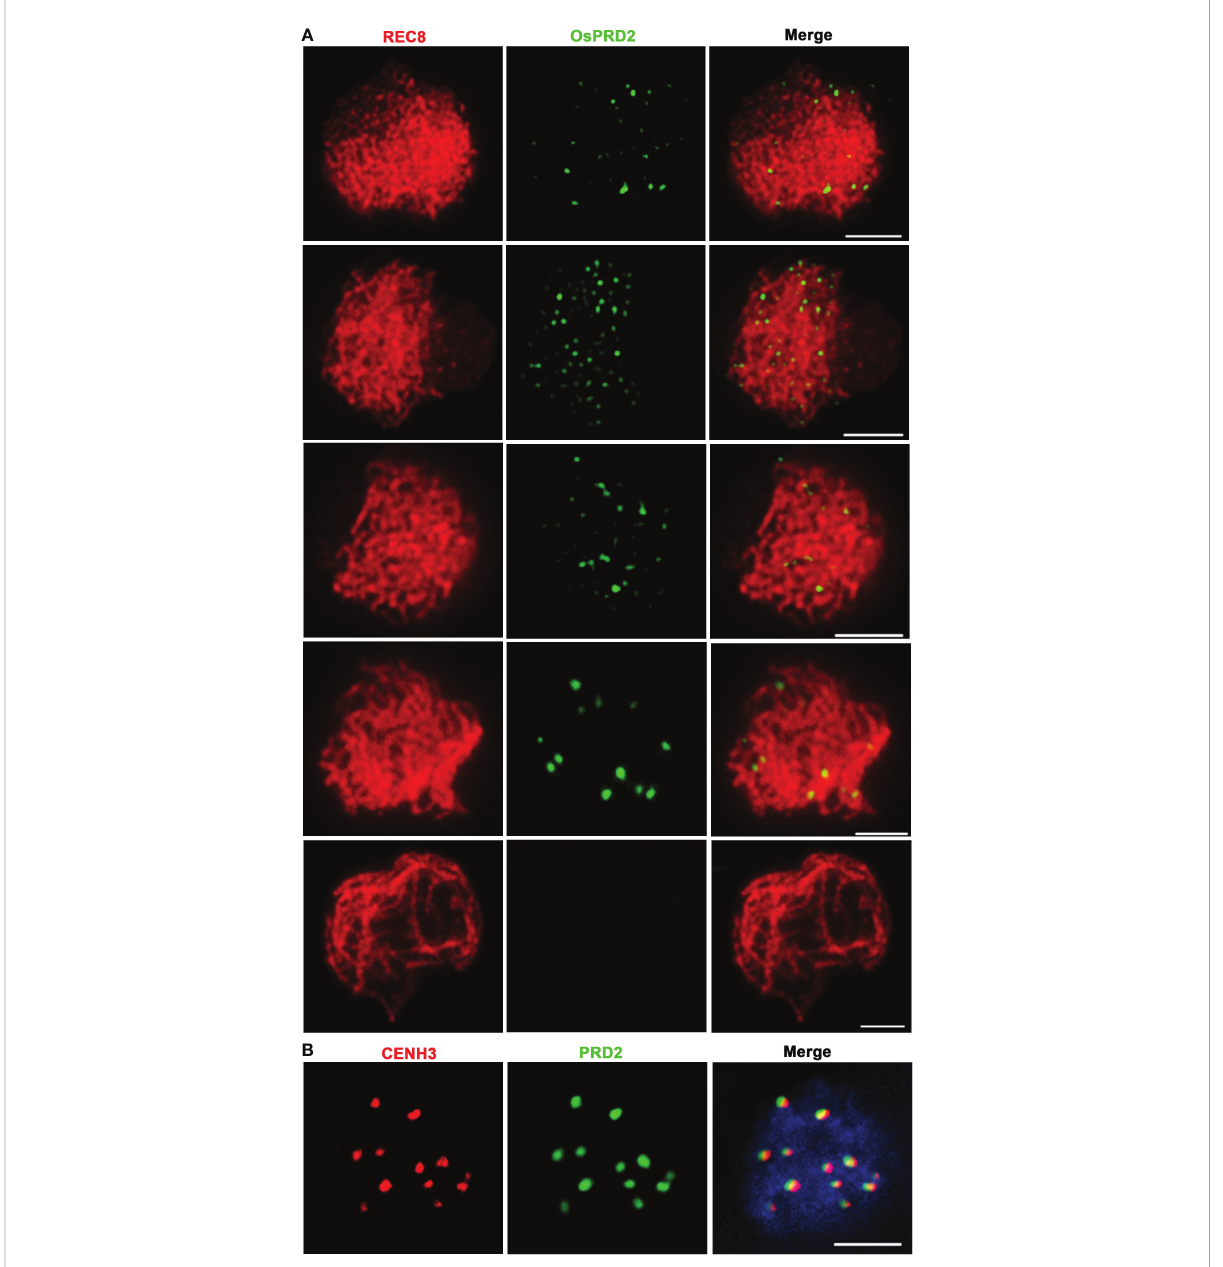
FIGURE 7 PRD2 co-localized with CENH3 in later meiotic prophase. (A) is PRD2 localization during prophase I in wild type; (B) is PRD2 and CENH3 co- localization in wild-type zygotene. Bar=2 m